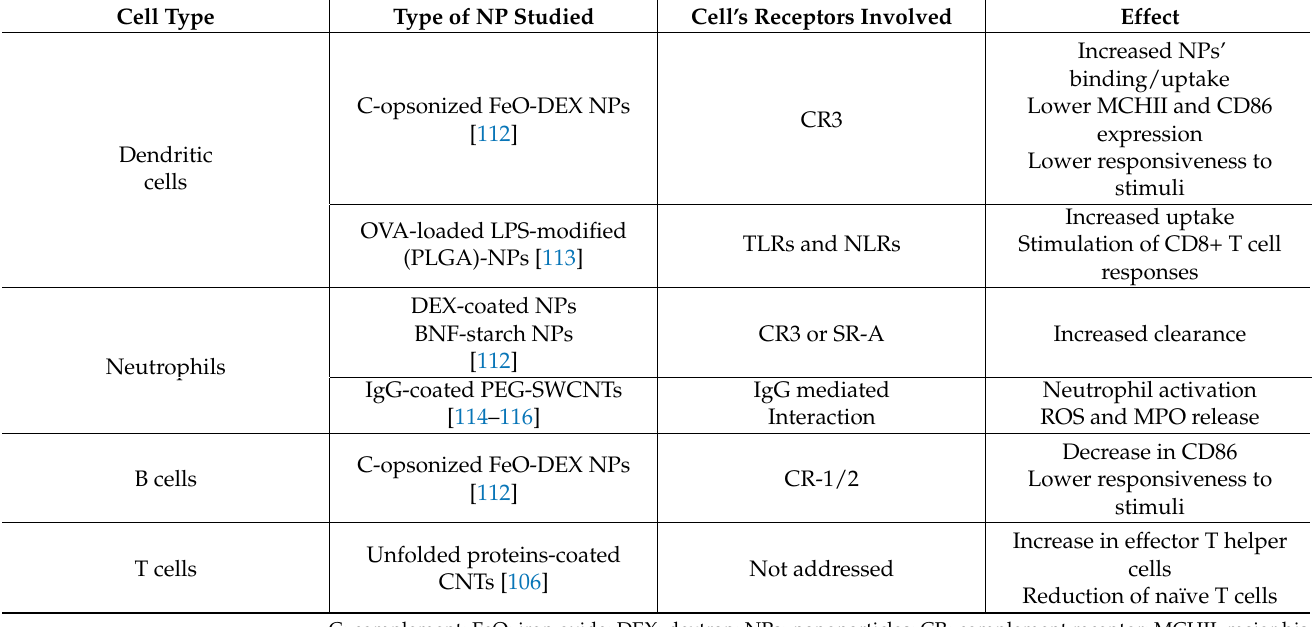
Table 2. PC and interaction with immune system cells other than